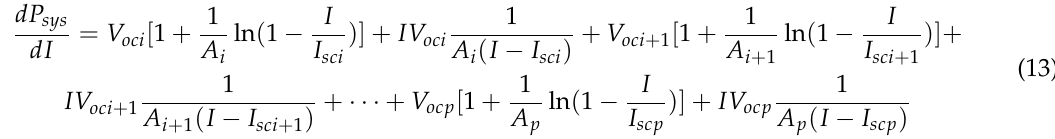
Figure 1. Equivalent circuit of the photovoltaic (PV) module.